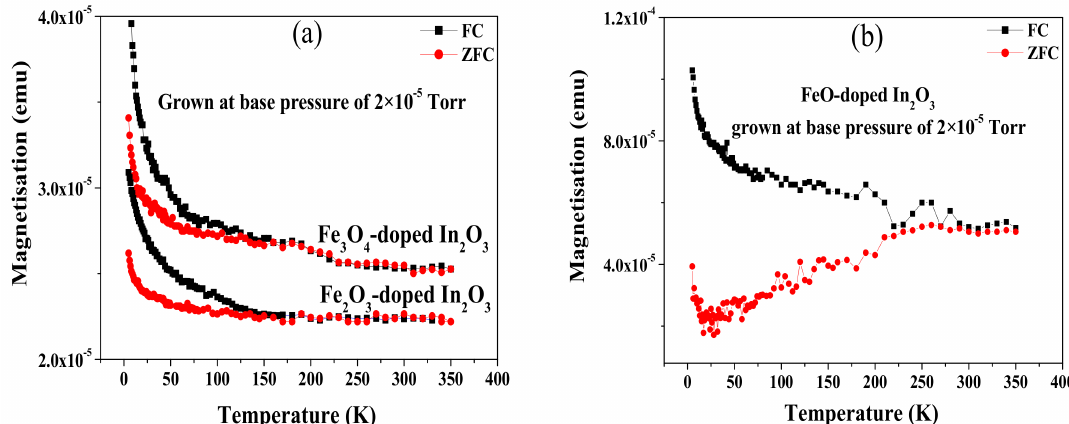
Figure 5. Field cooled (FC) and zero field cooled (ZFC) magnetisation curves of the Fe-doped In 2 O 3 from Fe 3 O 4 and Fe 2 O 3 precursors in ( a ) and from FeO precursor in ( b ) where all samples were grown at a base pressure of 2 × 10 − 5